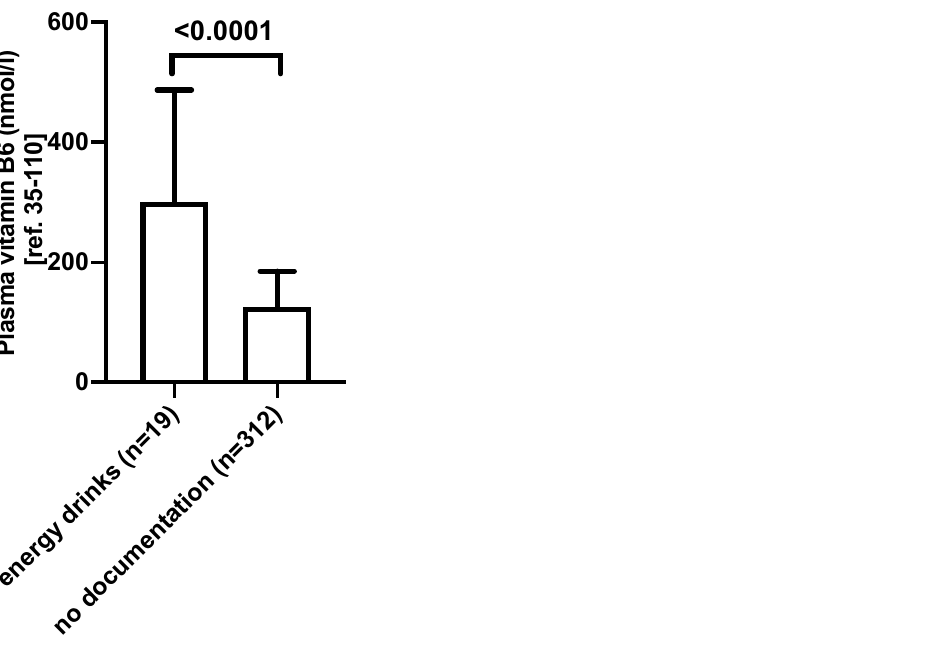
Figure 5. Plasma vitamin B6 levels in postbariatric patients with documented energy drink consumption. Vitamin B6 plasma level measurements in patients (n = 12) with reported energy drink intake compared to patients without documented energy drink intake (n = 193). Data are presented as median with interquartile range. Level of significance between the two groups was calculated with Mann–Whitney U-test. n number of plasma vitamin B6 measurements in 205 patients in